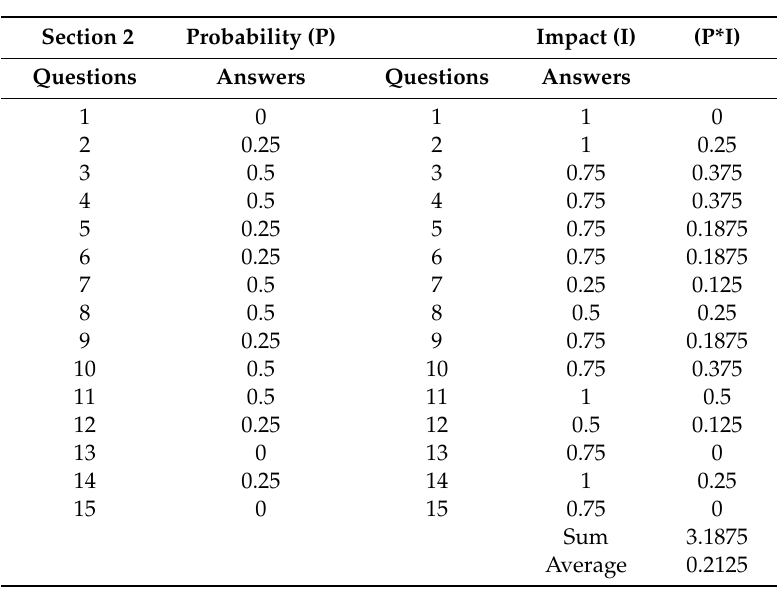
Table 5. The expert’s answers to questions of Section 2.